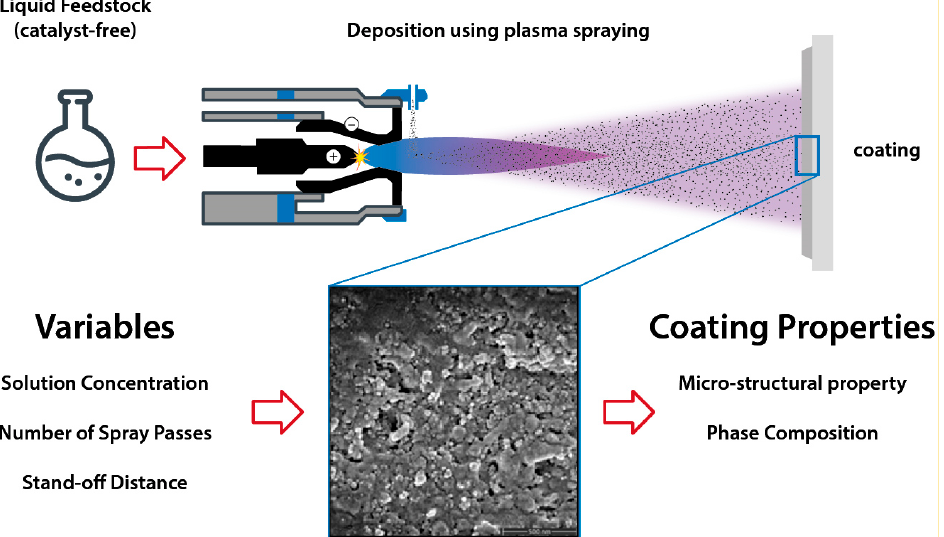
Figure 1. Process flowchart demonstrating the SPPS deposition of TiO 2 solution using a catalyst-free precursor with varied spray parameters and their influence on specific coating properties.